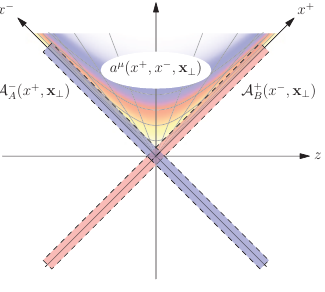
Figure 1. Minkowski diagram of the 3 + 1 dimensional collision problem. The background color fields and color and J μ are strongly peaked currents of the nuclei A μ A , B A , B around the light cone. The thin, but finite support along the longitudinal directions is indicated by red and blue rectangles. The color field of the Glasma a μ in the future light cone is produced due to the non-linear interactions of the high energy nuclei in the collision